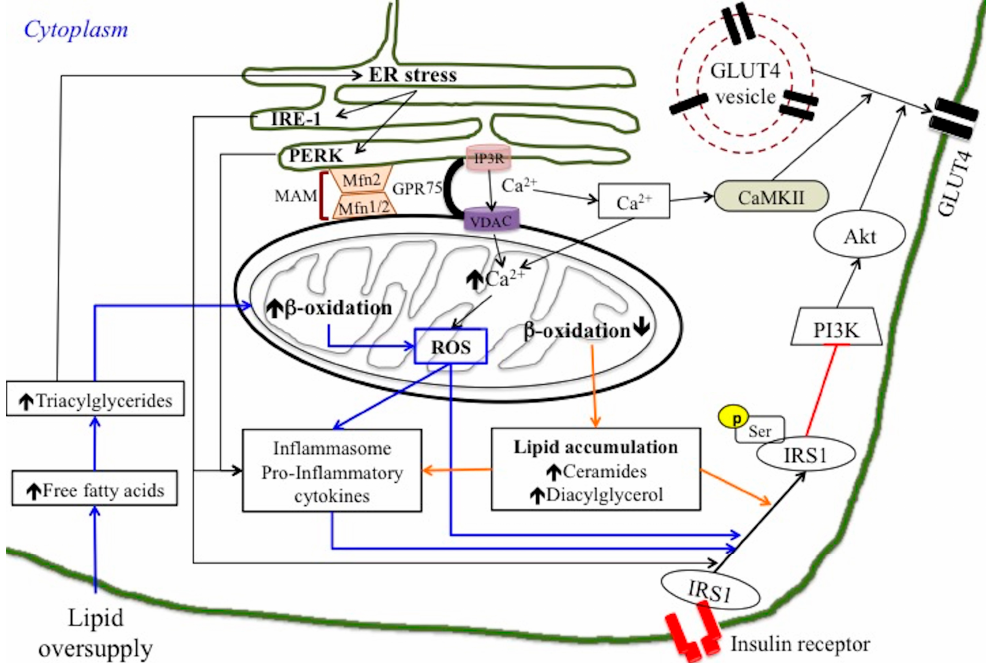
Figure 1. Overview of possible routes of lipid oversupply-induced insulin resistances associated with mitochondrial and endoplasmic reticulum (ER) stress. (Orange arrow) Mitochondrial dysfunction and lipotoxicity theory: lipid oversupply elicits reduction in mitochondrial β -oxidation that induces cytosolic ectopic accumulation of fatty acid metabolites, such as diacylglycerol and ceramides. These lipid metabolites impair insulin signalling pathways, directly or indirectly, through the activation of an inflammasome/pro-inflammatory pathway. (Blue arrow) ROS implication: lipid overload induces an increase in mitochondrial β -oxidation that stimulates ROS production. ROS can directly target protein involved in the glucose uptake process or activate the inflammasome, which initiates a series of inflammatory reactions in response to stress. ROS production may be also induced by excessive mitochondrial Ca 2 + influx from ER. (Black arrow) ER stress induced by lipid oversupply directly actives inflammatory pathways and impairs insulin action. On the other hand, ER stress also trigger Ca 2 + mobilization towards mitochondria through mitochondria-associated endoplasmic reticulum membrane (MAM), where Mfn2 play a regulatory role. The subsequent opening of the mitochondrial transition pore leads to activation of inflammasome and inflammatory